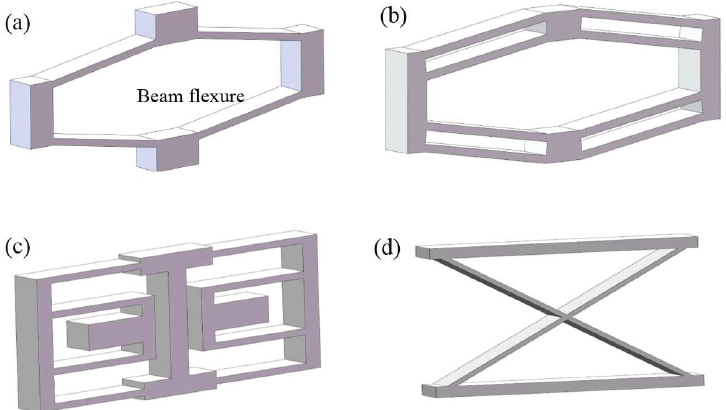
Figure 1. Typical distributed-compliance flexure mechanisms. ( a ) Traditional bridge-type am- plifier. ( b ) Compound bridge-type amplifier. ( c ) Compound double-parallelogram mechanism. ( d ) Cartwheel flexure